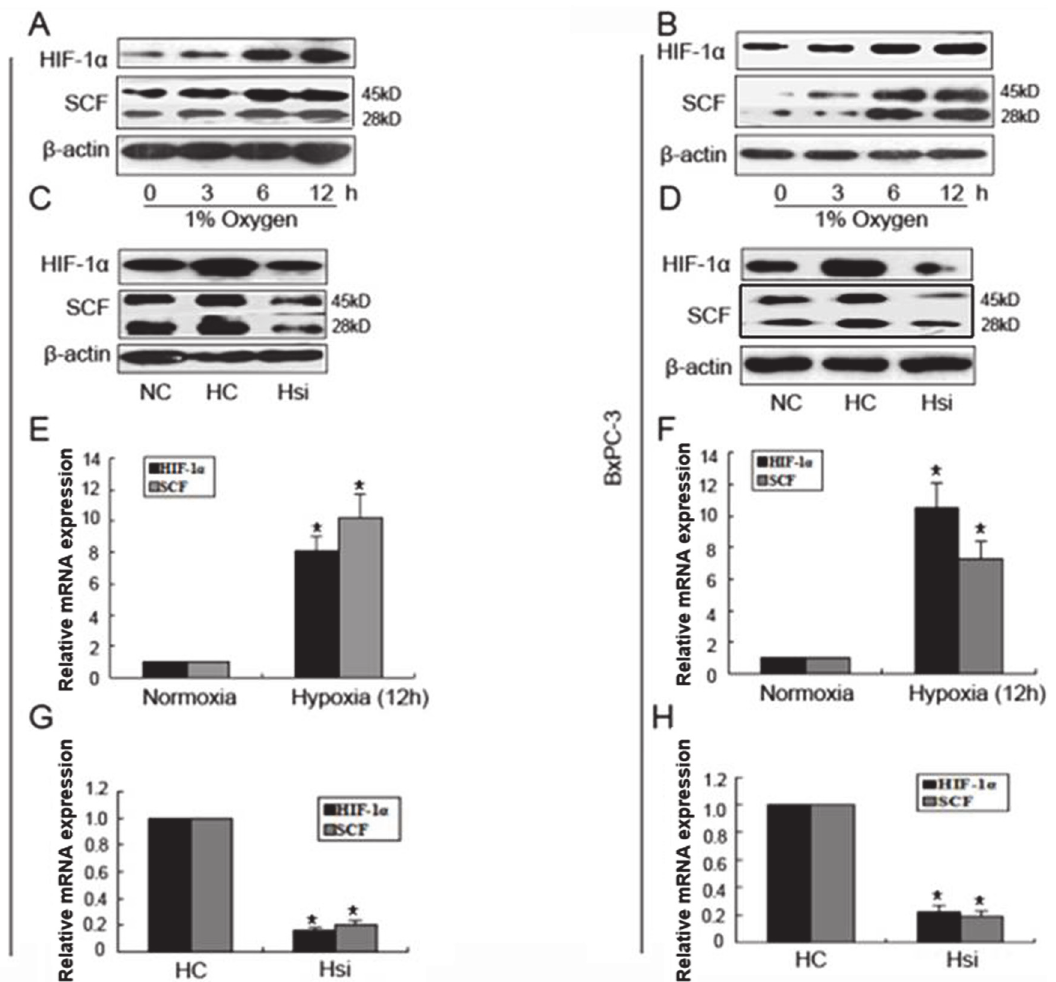
Fig 2. Expression of HIF-1 α and SCF protein and mRNA after different treatment. (A, B): Expression of HIF-1 α and SCF protein after hypoxia treatment. Two pancreatic cancer cell lines, PANC-1 and BxPC-3, were incubated under hypoxia at different time points (0, 3, 6, 12 hrs). Both of the protein expression of HIF-1 α and SCF were determined via Western blot. β -actin expression was used as the control. (C, D): Expression of HIF-1 α and SCF protein after transfected with siRNA targeting HIF-1 α . The PANC-1 and BxPC-3 cancer cells were transfected with siRNA targeting HIF-1 α for 48 hrs and incubated under hypoxia for 12 hrs. The protein expressions of HIF-1 α and SCF were then determined via Western blot. (E, F, G, H): Expression of HIF-1 α and SCF mRNA after different treatments. After hypoxia treatment or interference of siRNA-HIF-1 α treatment in PANC-1 and BxPC-3 cancer cells, the mRNA expressions were quantified via real-time PCR. Data from three experimental determinations and bars indicate the SD, p < 0.05 vs. control.